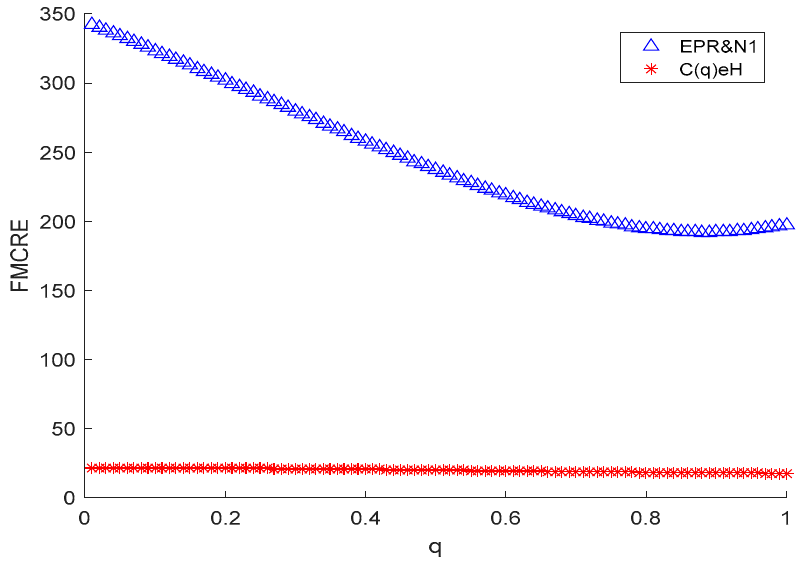
H H C e . Figure 8. The fractional cumulative residual MRE of EPR, N1 time series, and the values of C ( q ) e q H C e . q